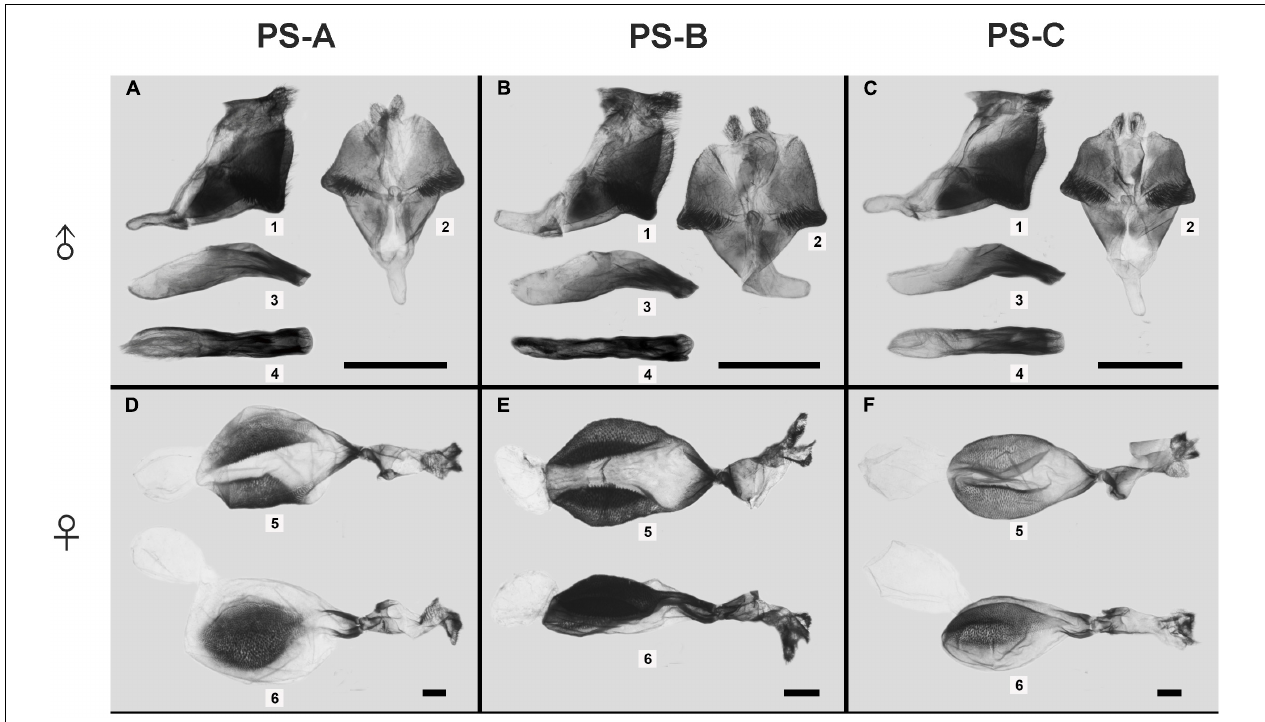
FIGURE 4 | The male and female genitalia of the three Parantica sita lineages: PS-A, PS-B, and PS-C. (A–C) Male external genitalia (1, genitalia in lateral view; 2, genitalia in dorsal view; 3, aedeagus in lateral view; 4, aedeagus in dorsal view); (D–F) Female genitalia (5, dorsal view; 6, lateral view). Scale bar is 1 mm.